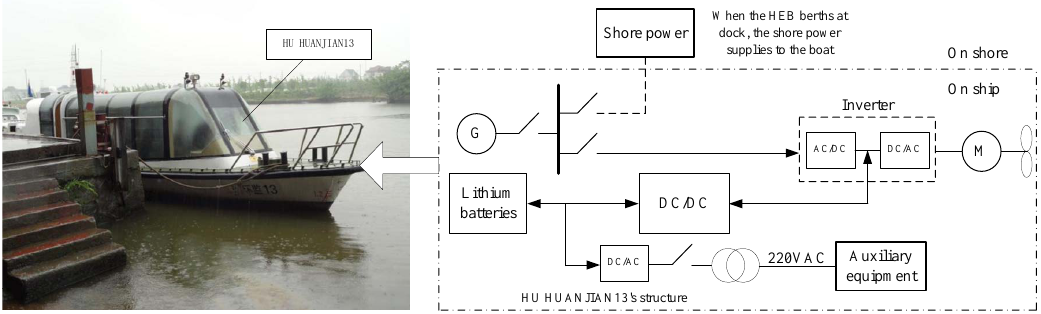
Figure 1. Schematic structure of a series hybrid power inland waterway boat. HEB: hybrid electric